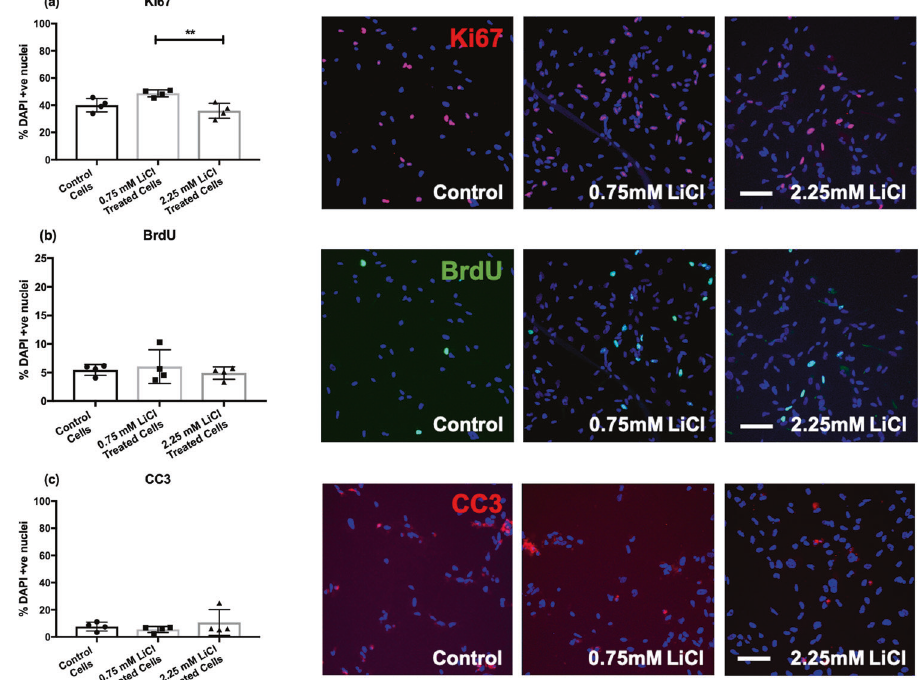
Fig. 2 Bar charts showing the percentage of Ki67, BrdU, and CC3 positive cells in those treated chronically with a vehicle control (0 mM), low (0.75 mM), or high (2.25 mM) dose of lithium chloride. The bar charts (left) show the percentage of Ki67 ( a ), BrdU ( b ), and CC3 ( c ) positive cells relative to the percentage of DAPI stained nuclei in control and lithium-treated cells. Bar heights correspond to means, and the standard errors of the mean (S.E.M.) are indicated. Each data point represents one biological replicate ( N = 4). * represents an uncorrected P ≤ 0.05. ** represents an uncorrected P ≤ 0.01. *** represents an uncorrected P ≤ 0.001. Each of the images (right) are representative of a fi eld of immuno-stained cells, taken using a 10X objective with the CellInsight High Content Screening Platform. Each image includes the nuclear marker DAPI in blue. Scale bar = 100 μ